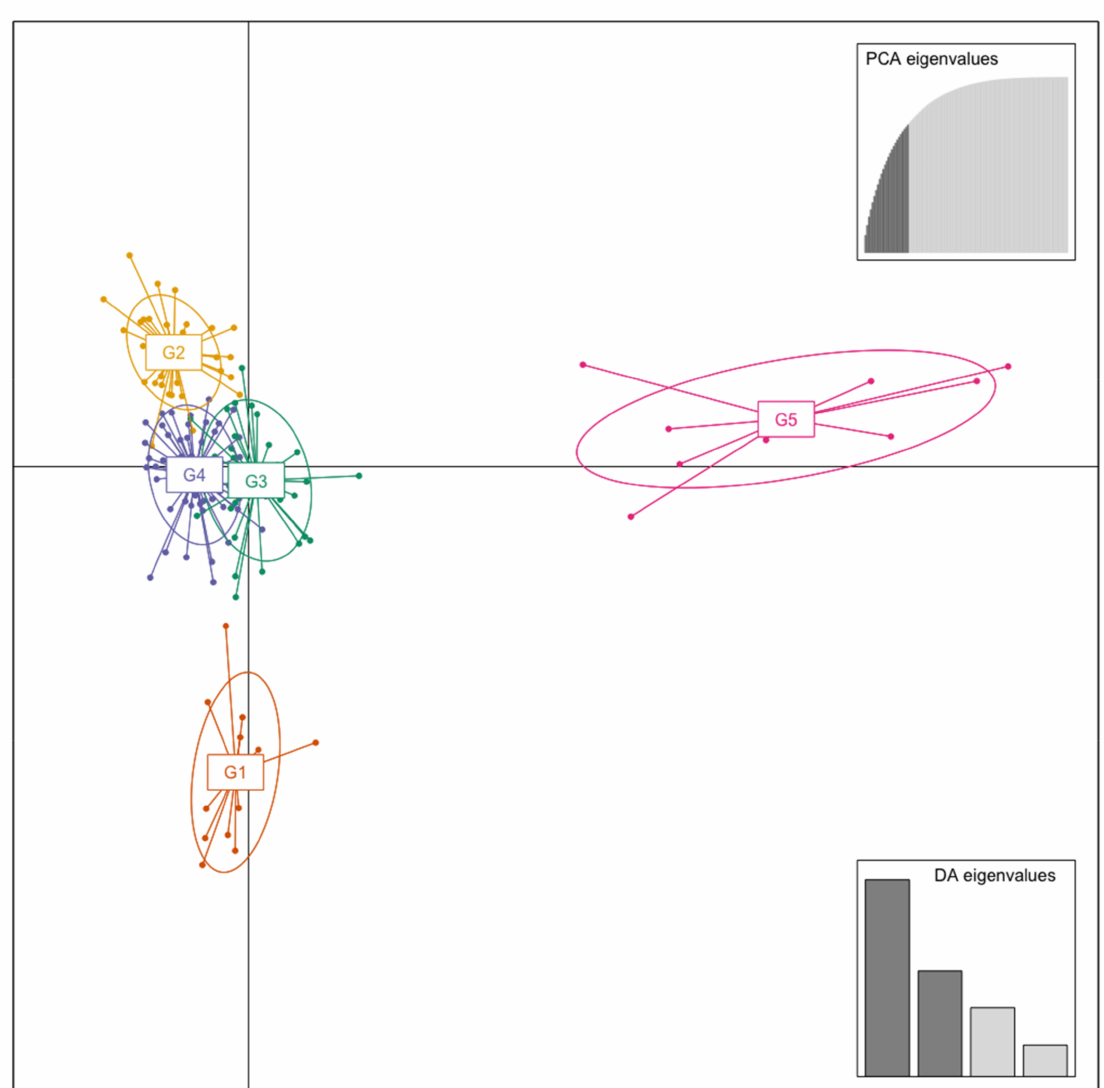
Figure 3. Scatterplot of discriminant analysis of principal components (DAPC) of population structure of 115 interspecific plum × apricot hybrids accessions and 27 reference genotypes (diploid plums and apricots) using eight SSR markers. The axes represent the first two linear discriminants (LD1 and LD2) according to the discriminant analysis functions (DA) eigenvalues. Four discriminant analysis functions (DA) eigenvalues and 25 principal component analysis (PCA) eigenvalues were retained during analyses to describe the relationship between the five groups. Each dot represents an accession, and each colored circle represents a group identified by DAPC analysis. G1 = group formed mainly by advanced selections (orange), G2 = group with more commercial cultivars (yellow), G3 = group with more reference genotypes (green), G4 = largest group (purple), and G5 = apricot group